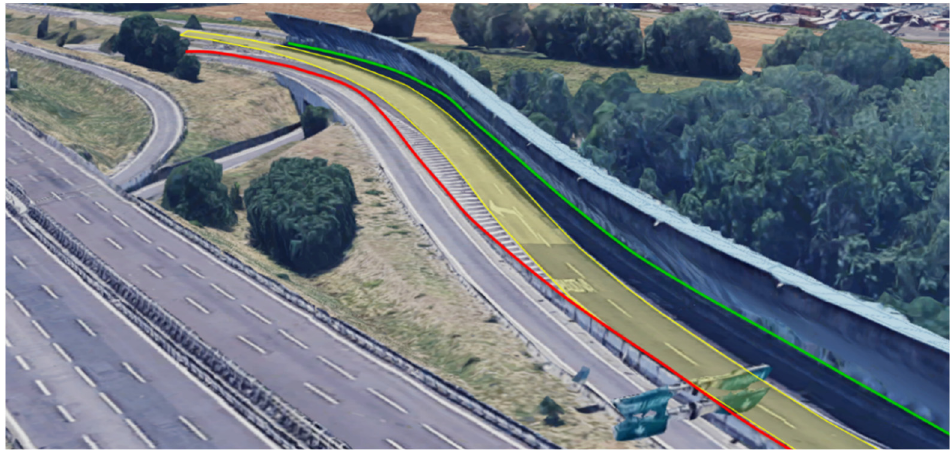
Figure 2. Example of a diverging line created by the roadside elements (median safety barrier and noise barrier), image from Google Maps.